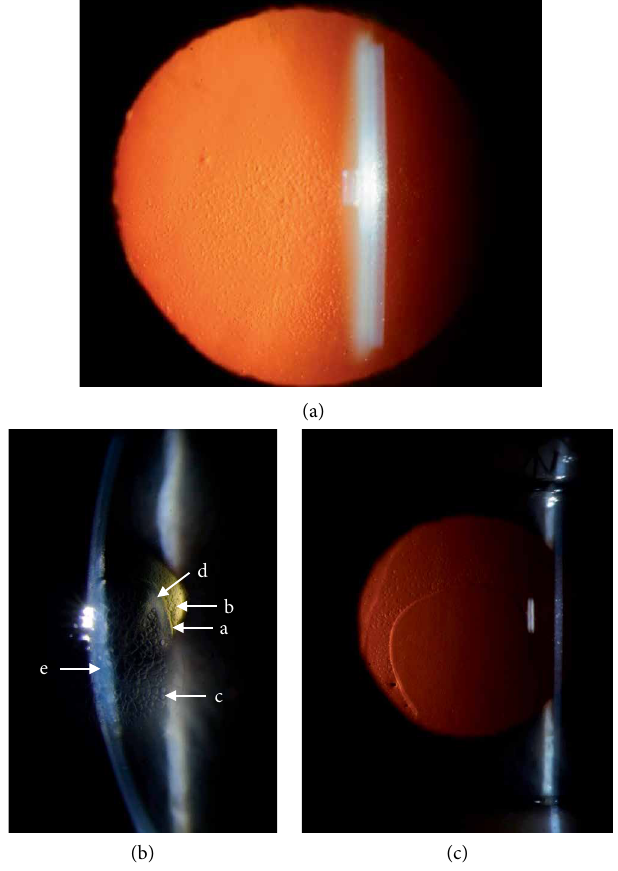
Figure 1: Slit lamp biomicroscopy photos pre- and post-DSO surgery for the left eye. (a) Preoperative red reflex photo with a dilated pupil shows confluent guttae in the visual axis, slightly greater in the inferior half of the visual axis compared to superior half. The peripheral cornea is relatively spared of guttae. (b) Slit photo through the central cornea at 1 week post-DSO surgery demonstrates a. the edge of the descemetorhexis; b. guttae outside the area of Descemet’s stripping; c. reticular epithelial edema; d. peripheral ring of corneal clearing without edema in presumed area of endothelial healing; and e. corneal stromal edema. (c) One month postoperative red reflex photo shows inferocentral descemetorhexis with clear visual axis without guttae and peripheral nonconfluent